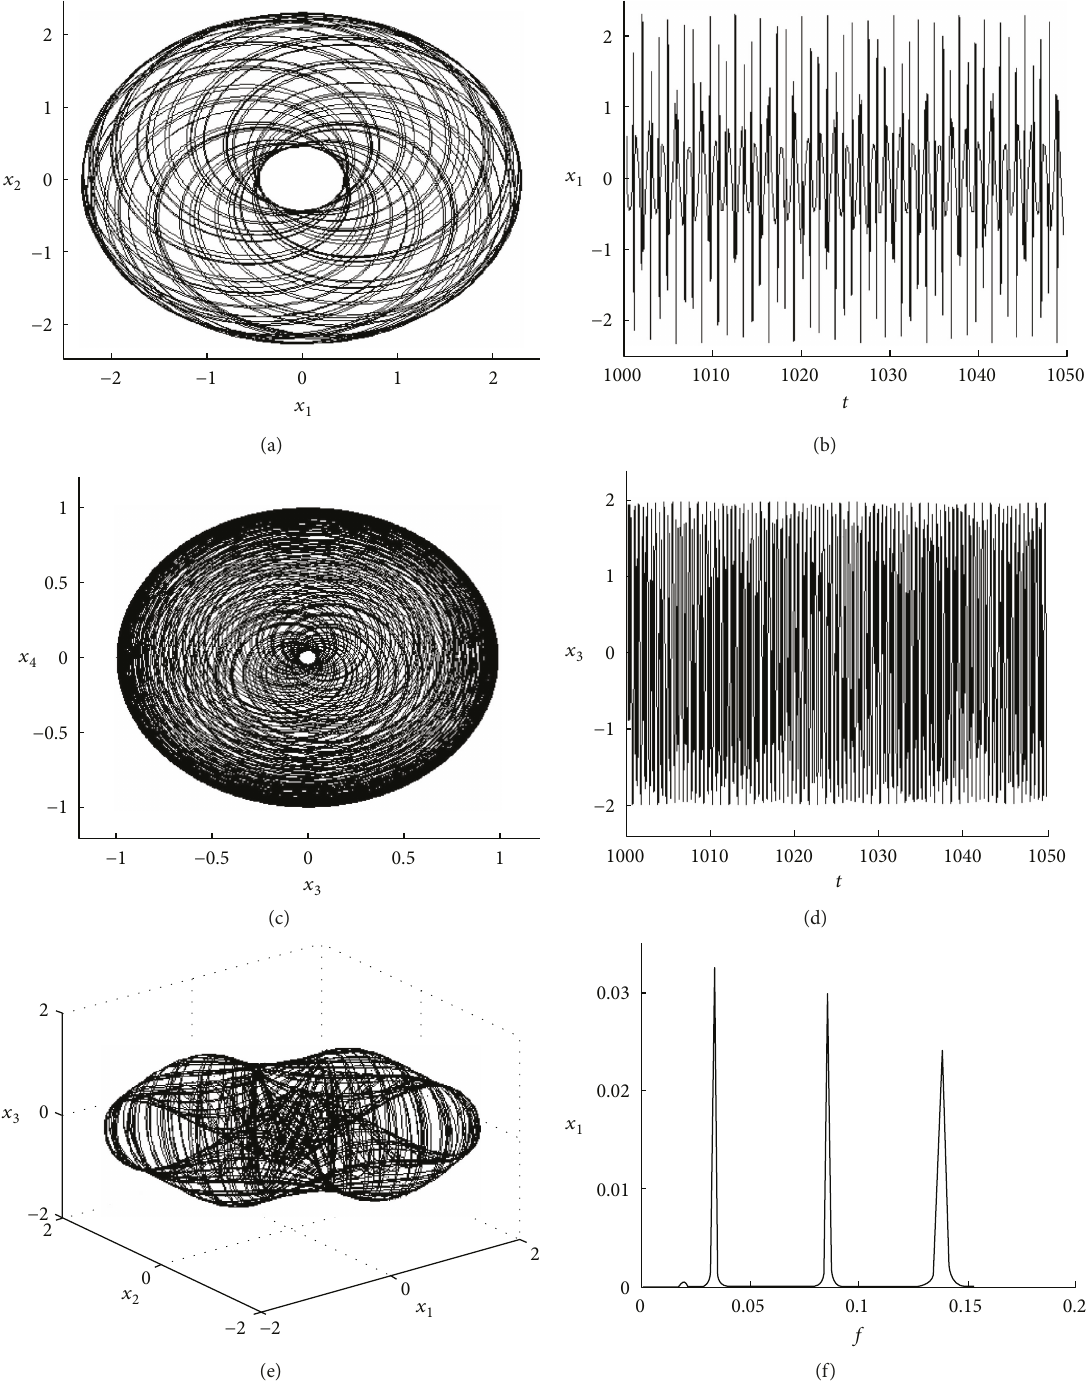
Figure 8: The multiperiodic motion of the blade with varying rotating speeds when Ω the waveform on the plane t , x the three-dimensional space x